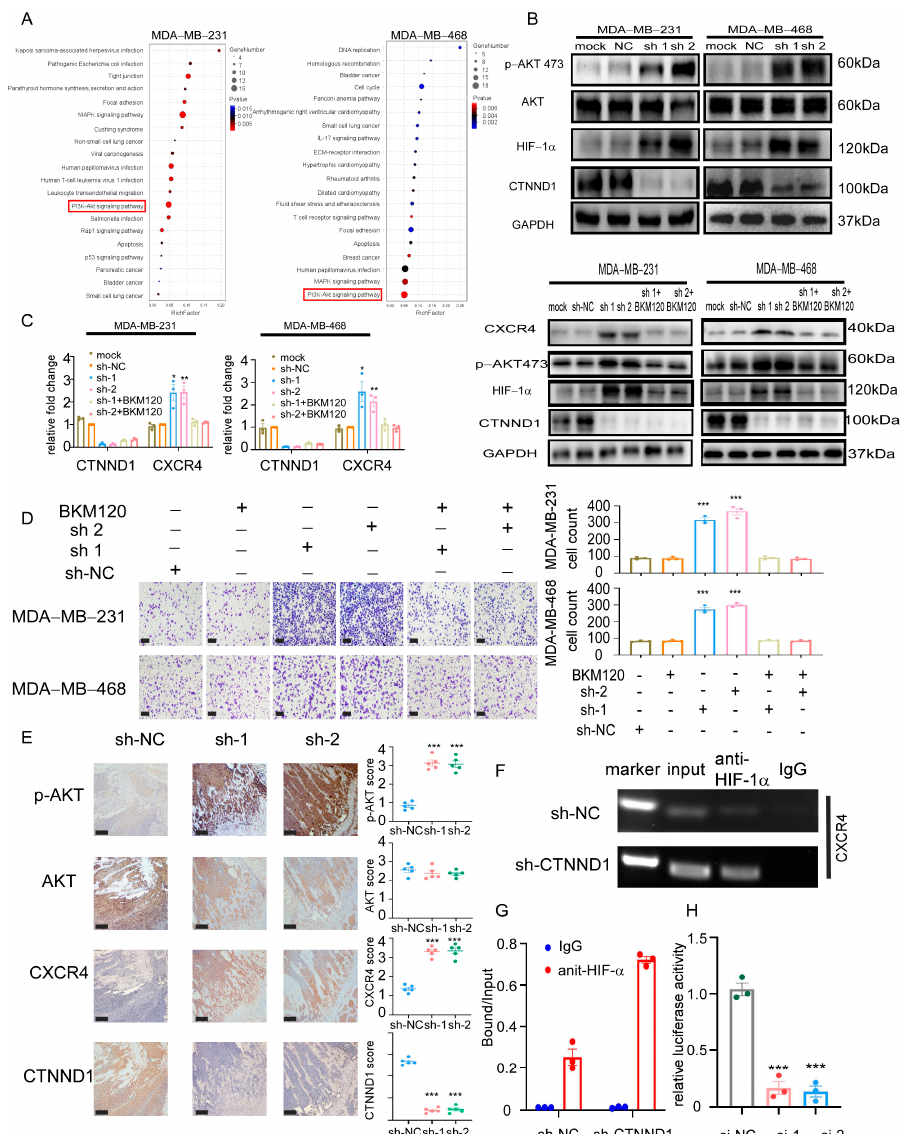
Figure 5. Knockdown of CTNND1 upregulates CXCR4 via activation of PI3K/AKT/HIF-1 α pathway. ( A ) KEGG pathway analysis of RNA sequencing between cells with sh-NC and sh-CTNND1 in MDA- MB-231 and MDA-MB-468 cells. ( B ) Immunoblotting of verifying activation of PI3K/AKT/HIF-1 α pathway. ( C ) Expression of CXCR4 by qRT-PCR (left) and immunoblotting (right) in cells with CTNND1 knockdown or BKM120. ( D ) Images and quantification of chemotaxis of cells with CTNND1 knockdown or BKM120 in the upper chamber and CXCL12 in the bottom chamber. Scale bar: 200 µ m. ( E ) IHC staining of AKT, p-AKT and CXCR4 in the bone of mice withEO771 CTNND1KD . Scale bar: 200 µ m, T: tumor, B: bone, M: bone marrow. ( F ) Chromatin immunoprecipitation (ChIP) assay of the enrichment of HIF-1 α at the CXCR4 promoter relative to IgG in MDA-MB-231 cells transduced with sh-CTNND1. ( G ) The enrichment of HIF-1 α at the CXCR4 promoter relative to Input in MDA-MB-231 cells transduced with sh-CTNND1 by CHIP-qPCR. ( H ) Luciferase reporter assay for the CXCR4 promoter construct transfected in MDA-MB-231 cells. * p < 0.05, ** p < 0.01, *** p < 0.005. Error bars indicate Standard Error of Mean